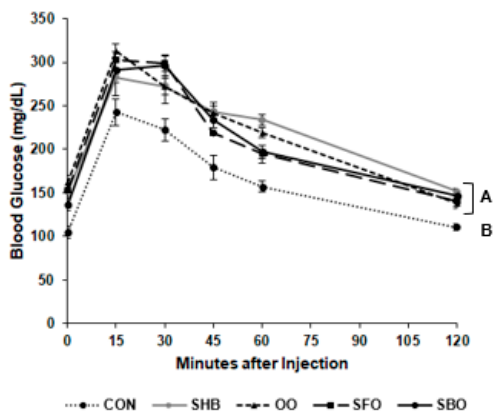
Figure 2. Blood glucose level during intraperitoneal glucose tolerance test. After 10 weeks of feeding the experimental diets, glucose was intraperitoneally injected to mice at 1.5 g/kg body weight after 8-h fasting. Blood was collected from the tail vein before the injection, and 15, 30, 45, 60, and 120 min after injection. Data are presented as means ± SEM ( n = 4 for each group). Different superscript letters A and B indicate significant differences between all the high fat diets (shea butter (SHB), olive oil (OO), safflower oil (SFO), and soybean oil (SBO)), which all have a common superscript A, and the control (CON) diet with superscript B ( P < 0.05) by Tukey’s multiple comparison test.